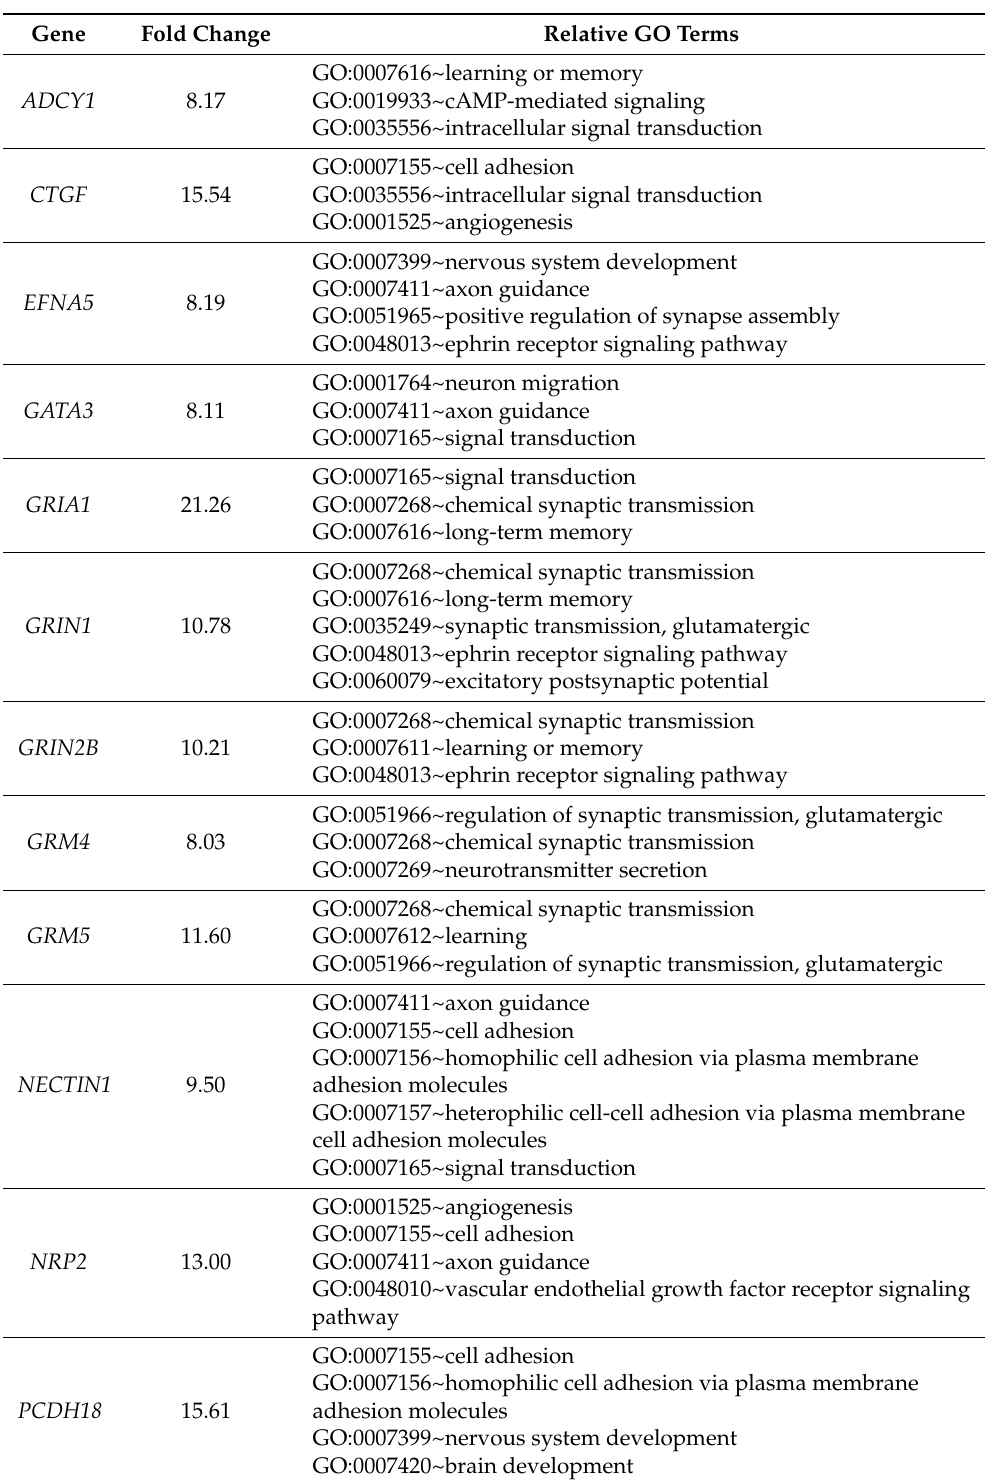
Table 3. DEGs with >8 fold change in the common crop brain after hypoxia